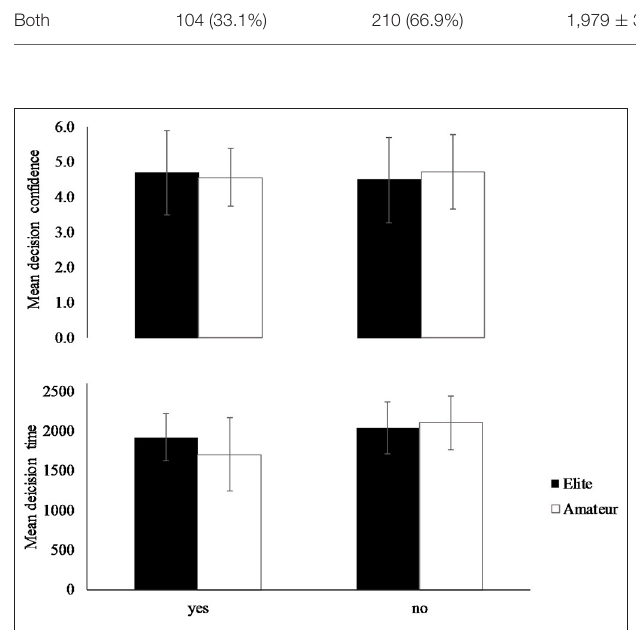
FIGURE 3 | Decision time (in ms) and decision confidence (Likert-type scale) of the selected (yes) and non-selected (no) best choice of elite and amateur players. Error bars indicate standard